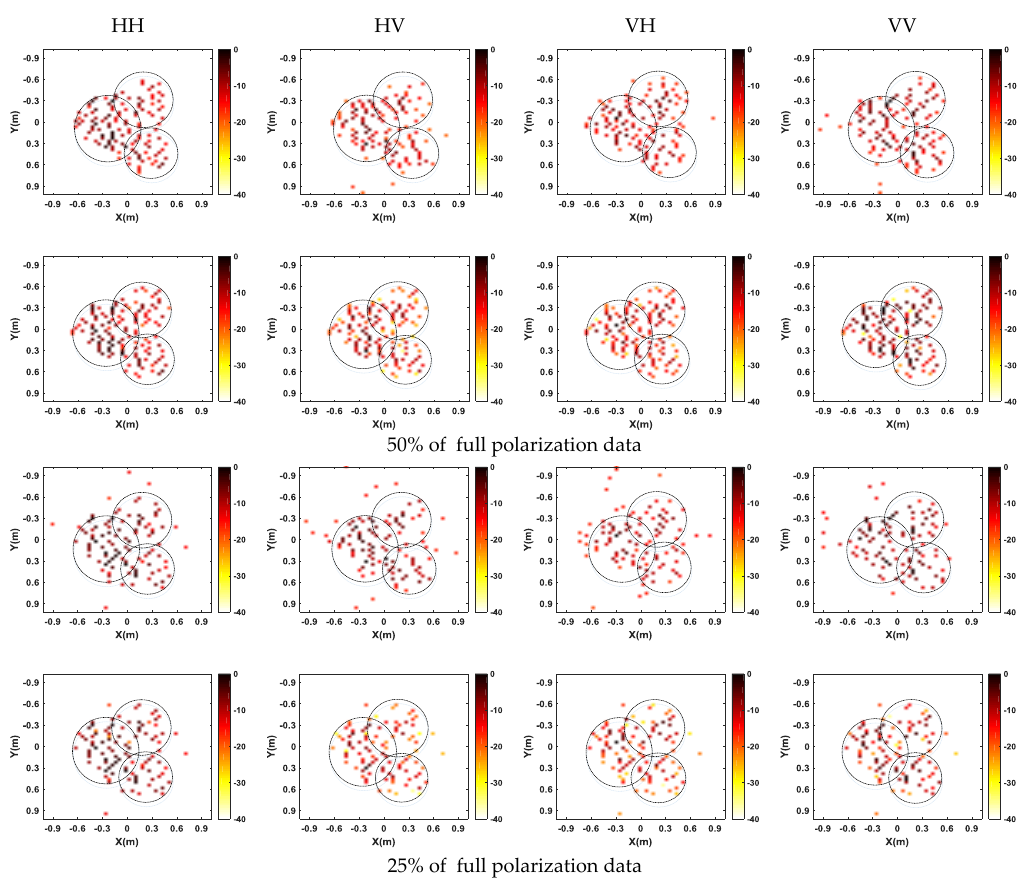
Figure 15. Imaging results for 50% and 30% of full polarization data. Up: single channel CS method; and down: multichannel joint CS method.